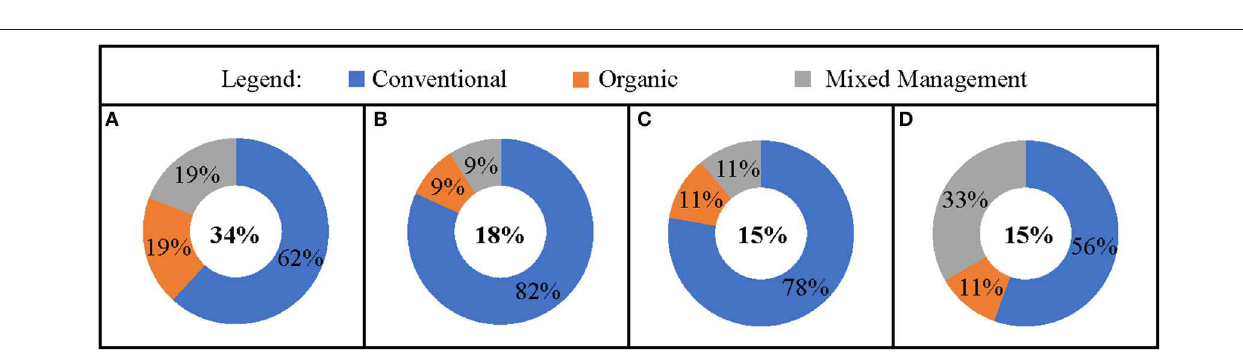
FIGURE 5 | Market, policy, and market access. (A) Total percentage (center) and the proportion of conventional, organic, and mixed management producers that reported market and policy factors that affect lentil production including tariffs/subsidies ( p < 0.0001), market variability ( p = 0.0308), labor costs, and fuel costs. (B) Total percentage (center) and the proportion of conventional, organic, and mixed management producers that reported market access for lentil that includes adequate access to a consistent market, distribution channels, and profitable market ( n = 61).